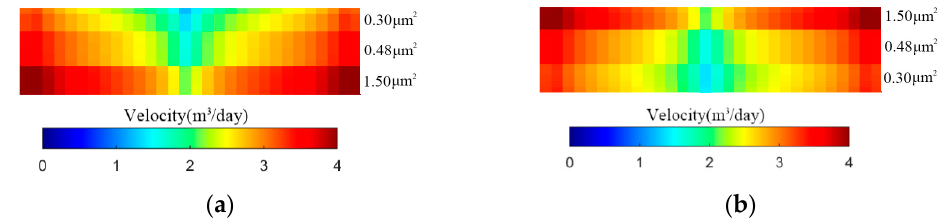
Figure 4. Fluid velocity profile near injector with different rhythm models. ( a ) Positive rhythm; ( b ) reverse